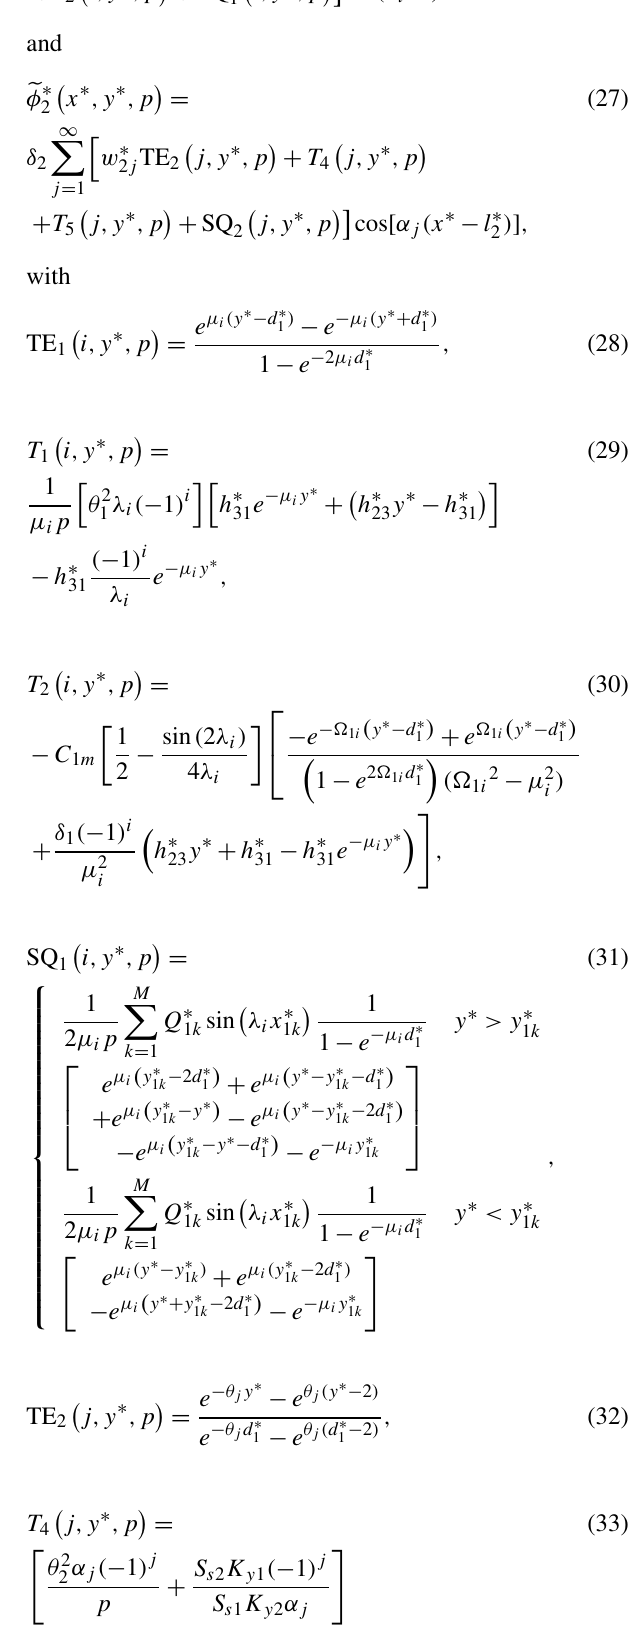
Table 1. Notations used in the